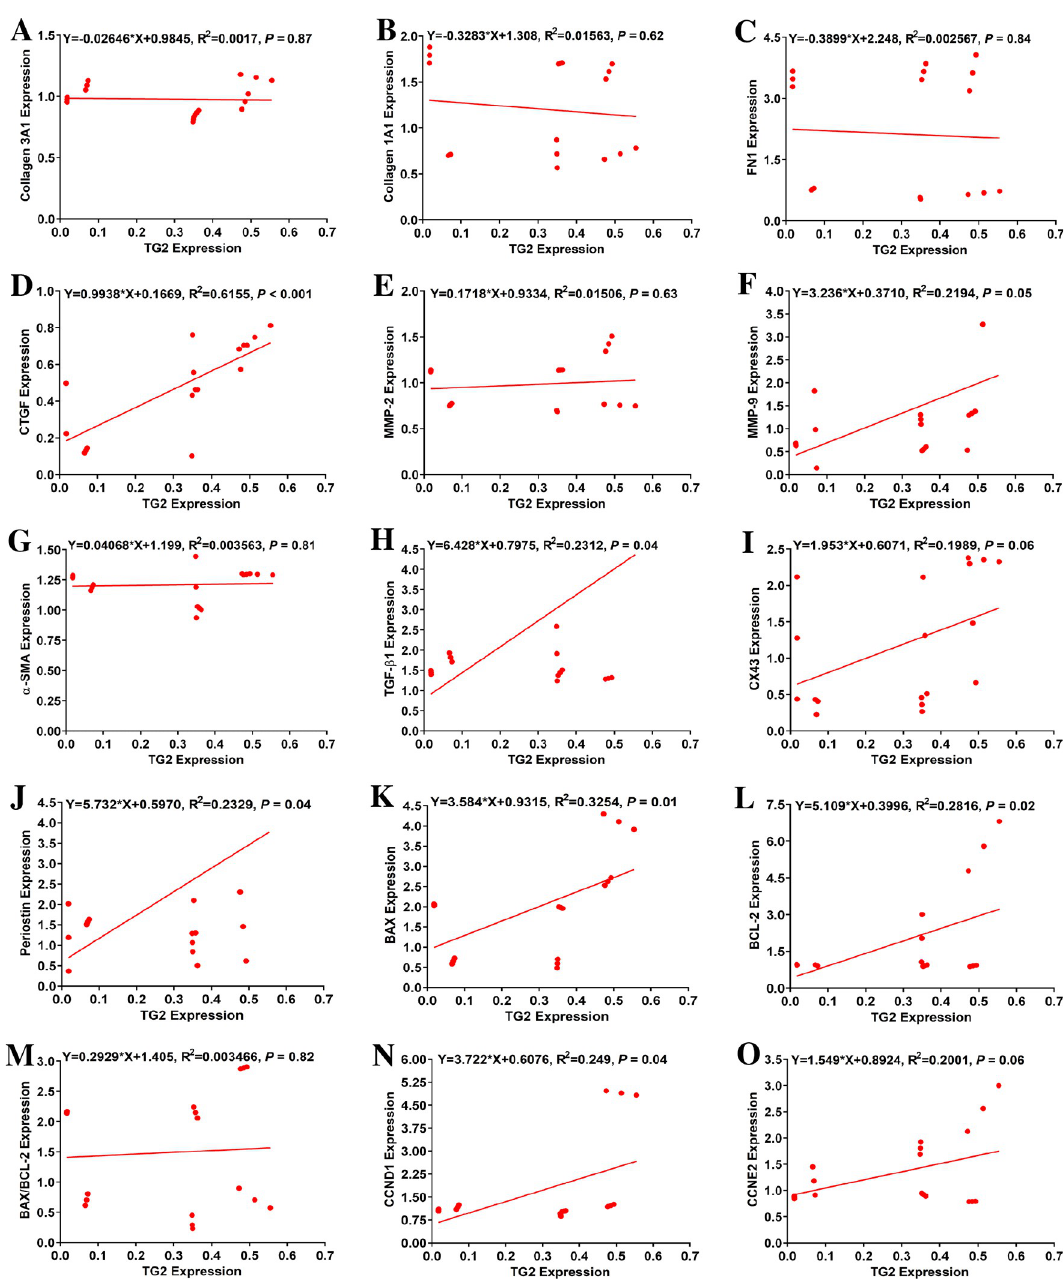
Fig 6. Transglutaminase 2 (TG2) mRNA expression was strongly correlated with mRNA expression of connective tissue growth factor (CTGF). Correlations between mRNA levels of TG2 following individual knockdown and mRNA levels of profibrotic, proliferation and apoptotic markers in neonatal rat ventricular fibroblasts (n = 18): (A) collagen 3A1 (COL 3A1), (B) collagen 1A1 (COL 1A1), (C) fibronectin 1 (FN 1), (D) CTGF, (E) matrix metalloproteinase-2 (MMP-2), (F) MMP-9, (G) α -smooth muscle actin ( α -SMA), (H) transforming growth factor β 1 (TGF- β 1), (I) connexin 43 (CX 43), (J) periostin, (K) BCL-2-associate X protein (BAX), (L) B-cell lymphoma 2 (BCL-2), (M) BAX/BCL-2 ratio, (N) cyclin D1 (CCND 1), and (O) cyclin E2 (CCNE 2). R 2 : Correlation coefficient; in the equations, (X) and (Y) respectively denote TG2 expression and expression of the profibrotic, proliferation or apoptotic markers.